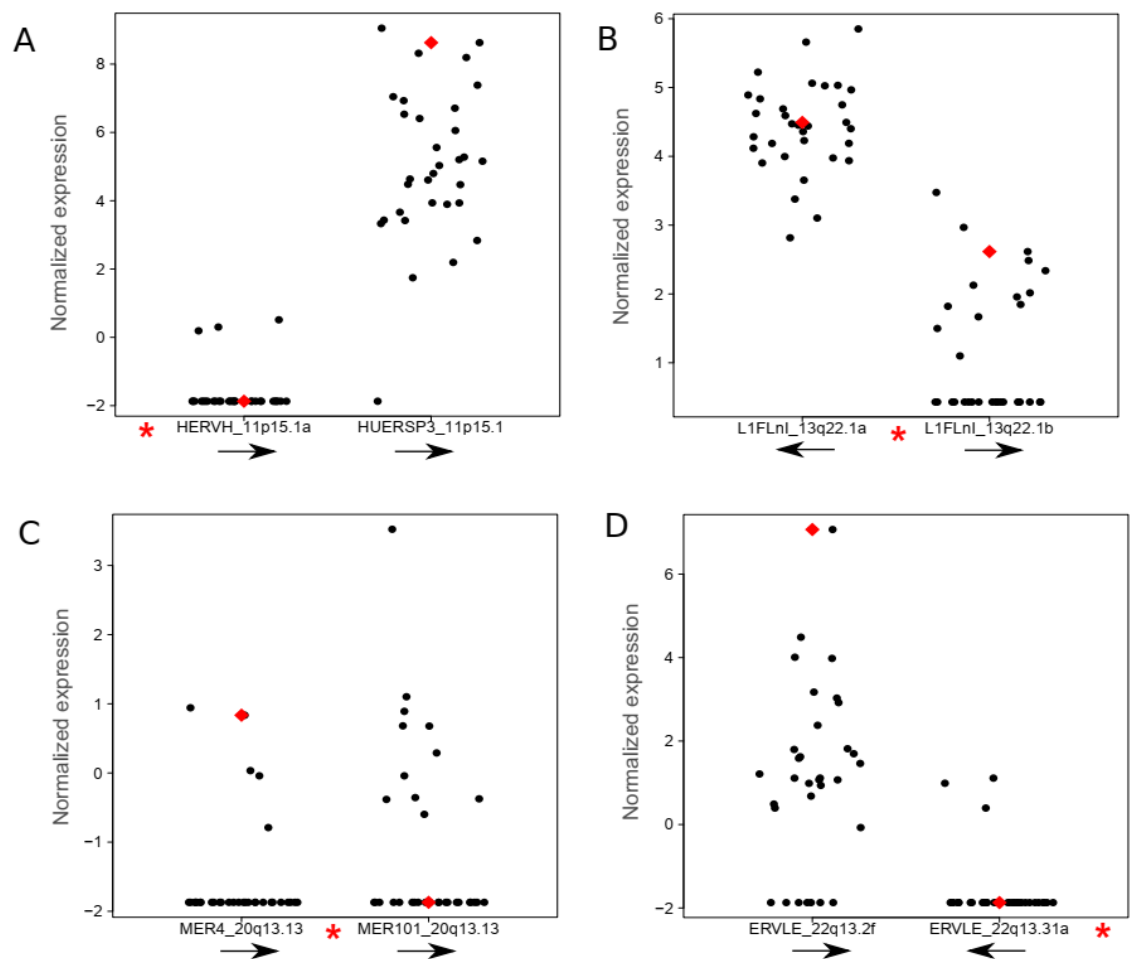
Figure 3. Retroelement expression near HPV integration sites. The normalized expression for the two nearest retroelements to the HPV integration site is shown in plots. ( A ) HERV-H and HUERSP3 , ( B ) L1Fnl_13q22.1a and L1Fnl_13q22.1b , ( C ) MER4 and MER101 , ( D ) ERVLE_22q13.31f and ERVLE_22q13.31a . Red dots represent the sample in which HPV is integrated in each case, while black dots depict the remaining samples without HPV integration. Red asterisks in the x -axis of each panel show the location of HPV integration relative to the two closest retroelements. All HPV are integrated in an antisense DNA orientation. Black arrows below each retroelement show their relative DNA orientation.